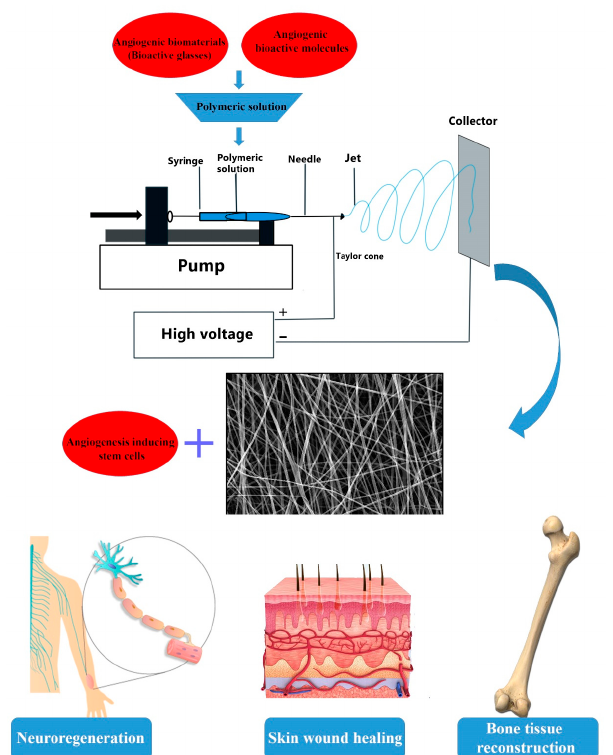
Figure 1. Neo-vessel formation can be induced by applying electrospun nanofibers containing pro-aniogenic bioactive molecules (e.g., vascular endothelial growth factor (VEGF)), angiogenesis inducing progenitor/stem cells (endothelial progenitor cells, EPCs), and angiogenic biomaterials (e.g., bioactive glasses). The fabricated angiogenic nanofibers could be applied for accelerating wound healing process for both hard (e.g., the bone) and soft tissues (e.g., the skin and the peripheral nerves). Prior experimental studies have confirmed the intrinsic angiogenic properties of some natural and synthetic polymers (e.g., collagen [109], elastin [110], and PLA [111]) and their composites (Table 4). As an illustration, hyaluronic acid oligosaccharide-modified collagen nanofibers have been proven to promote the proliferation and endothelialization by ECs [112]. However, scientific evidence is limited in the case of angiogenic natural polymers, and experimental studies on synthetic polymers are fairly more abundant than those with naturally-derived polymers. PCL-based electrospun